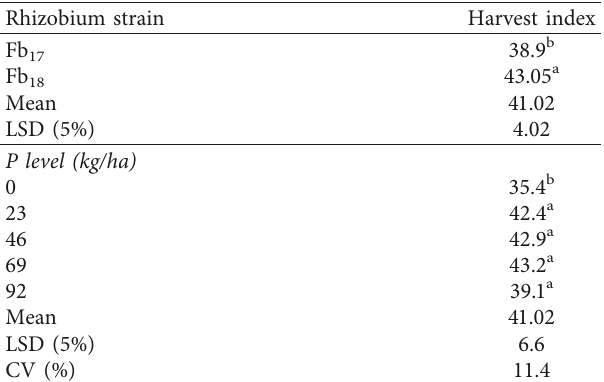
rates on harvest